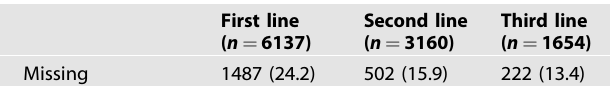
Table 1. Patient baseline demographics and